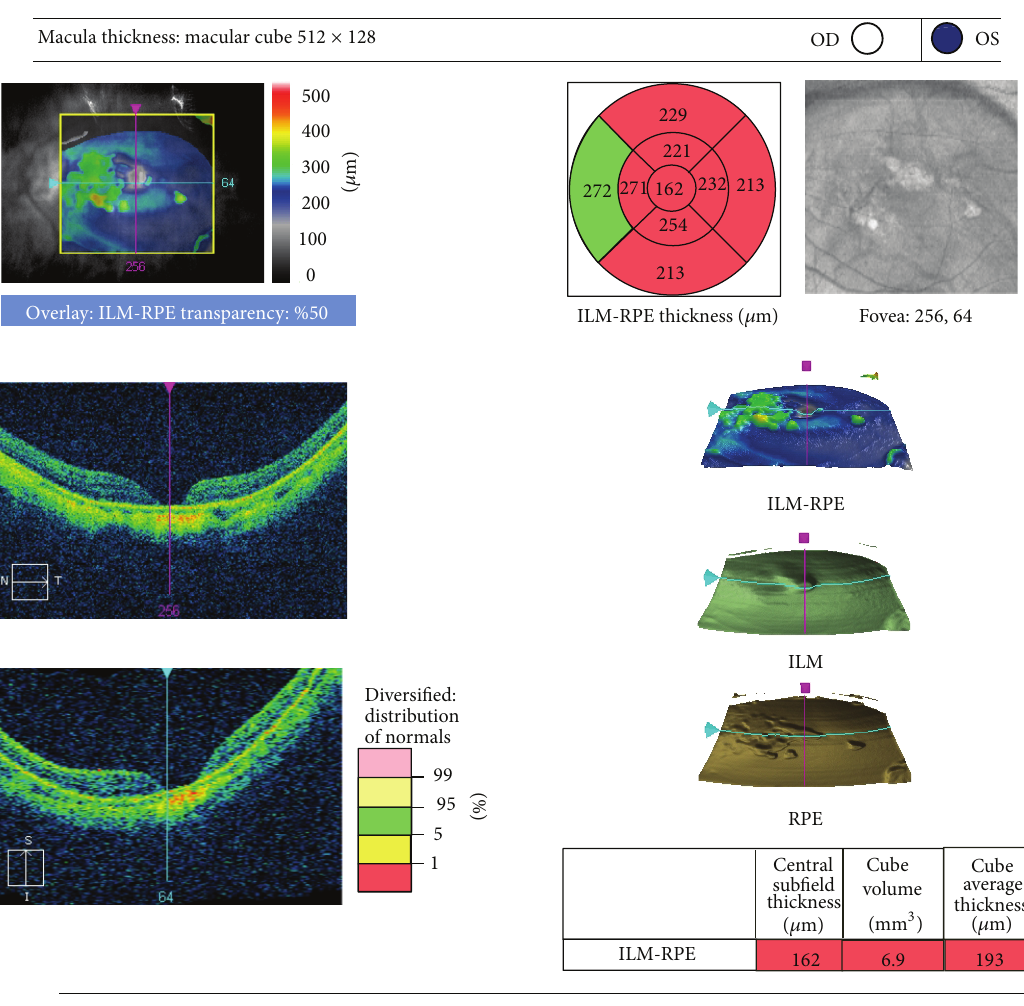
Figure 1: OCT picture of flat open macular hole of a male patient of 50 years old with recurrent RD after silicone oil